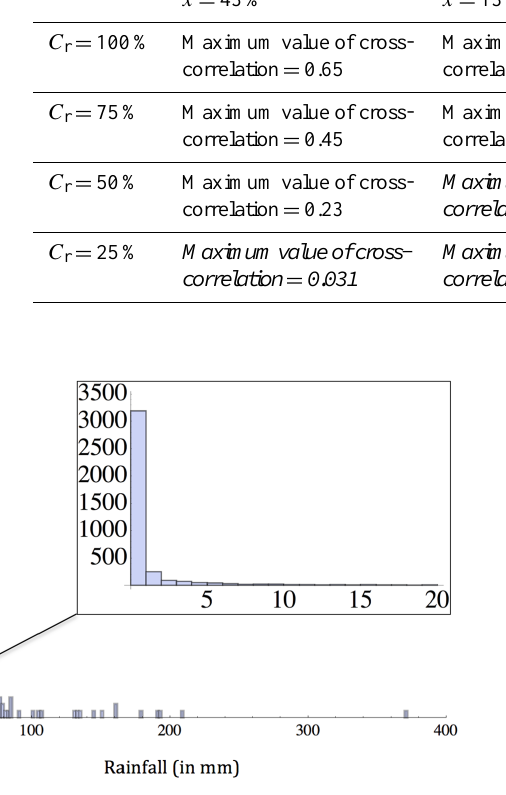
Figure 5. Histogram of rainfall for Réunion.